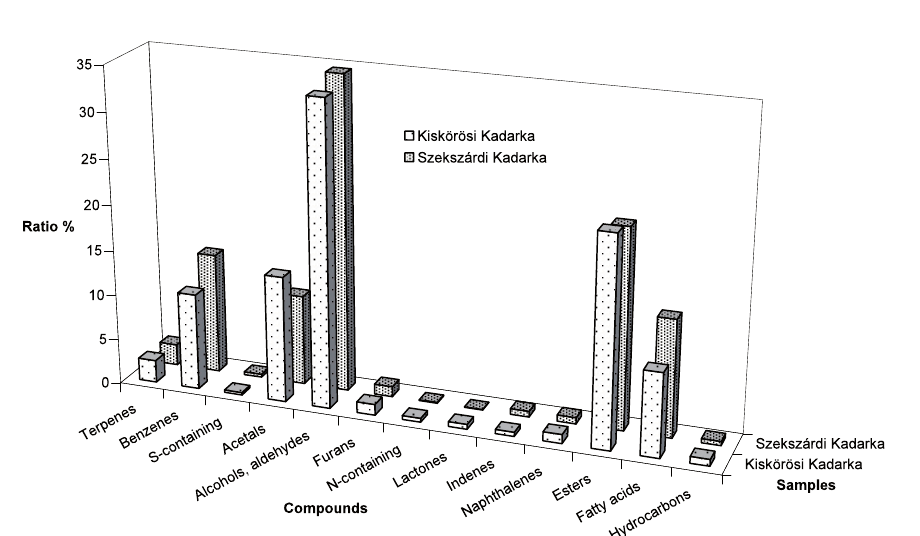
Fig. 3: The „comprehensive” visual representation of the volatile